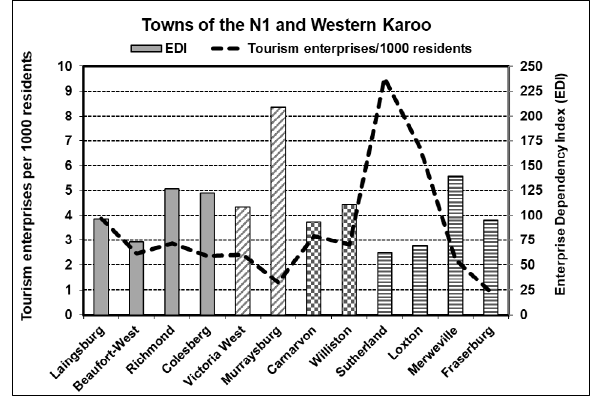
Comparison of the tourism sector strength (tourism enterprises per 1000 residents) and enterprise dependency indices (EDI) of towns on the N1 national road (even coloured) or closely linked to it (diagonal stripes) as well as towns close to the Square Kilometre Array development (square blocks) and other towns in the western part of the study area (horizontal stripes). Infrastructure (the N1 national road, i.e. the main road between Cape Town and Gauteng, astronomy observatories in the case of Sutherland, the SKA development in the case of Carnarvon and Williston) and the influence of individuals (Deon Meyer in the case of Loxton) contribute to T&H sector strength and the reduction of community